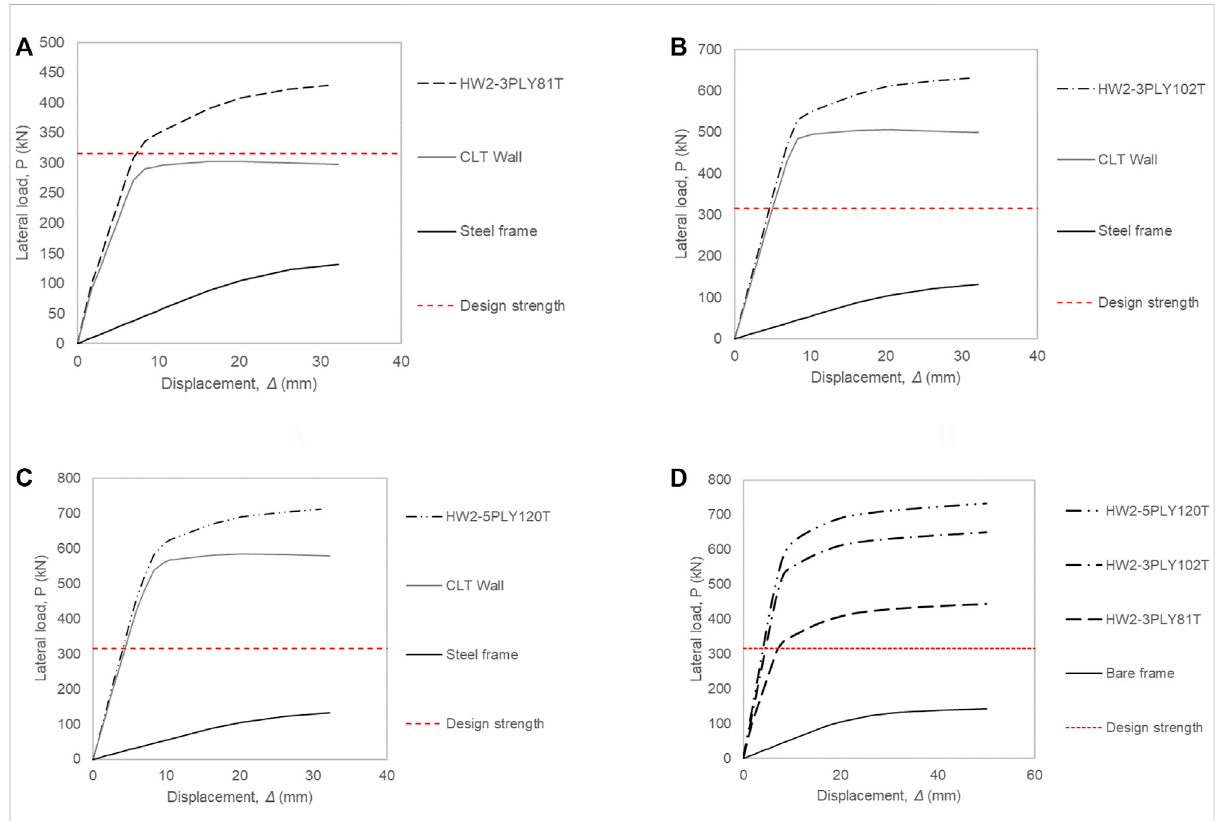
FIGURE 5 Behaviour of STSW specimens with connected in fi ll-frame interface (A) 3-ply (81 mm thick), (B) 3-ply (102 mm thick), (C) 5-ply (120 mm thick), (D) Comparative